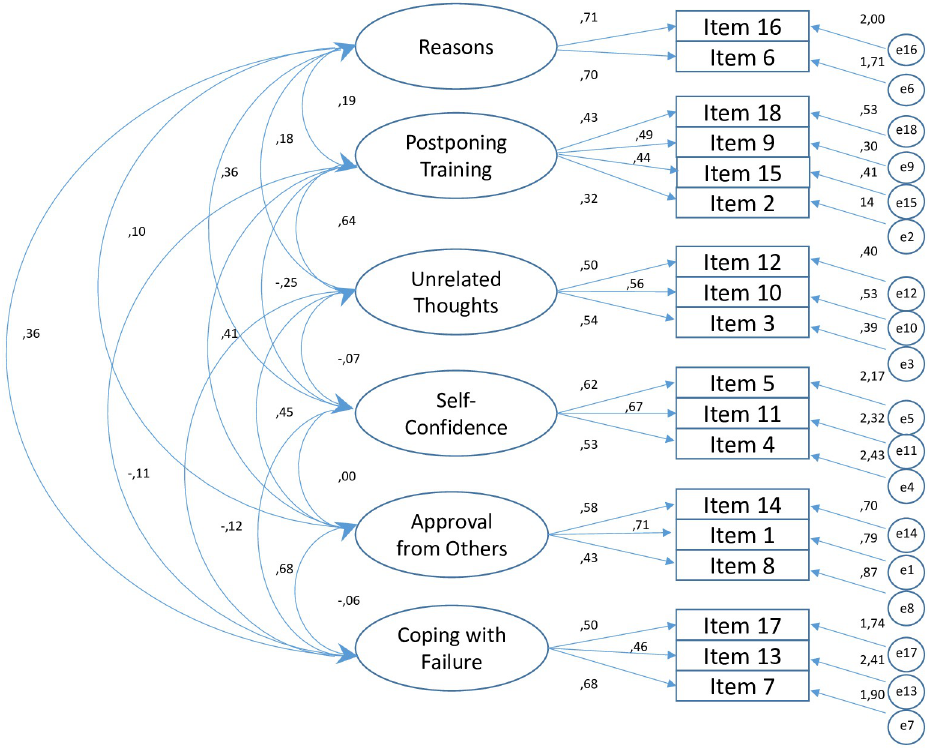
Fig 1. Standardized factor loadings and covariances of the confirmatory factor analysis